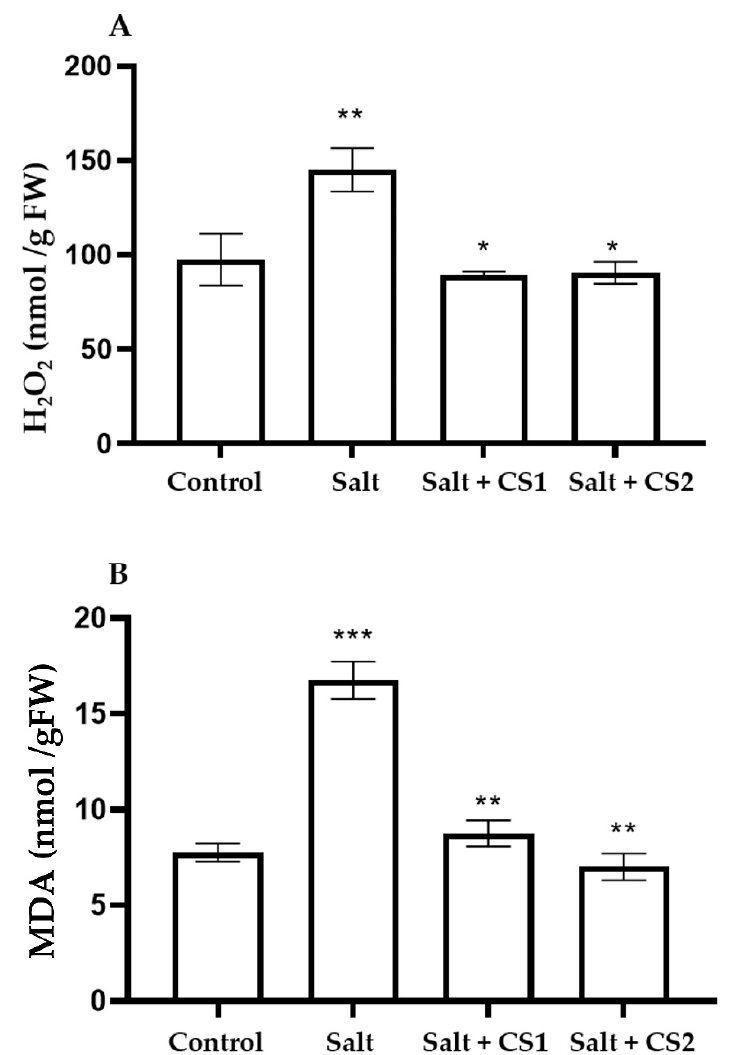
Figure 4. Chitosan (CS) reduces oxidative stress markers in sorghum under salt stress. ( A ) H 2 O 2 and ( B ) MDA content in control (0 mM NaCl) and salt (300 mM NaCl) treated sorghum supplemented with chitosan (CS1 = 0.25 mg/mL and CS2 = 0.5 mg/mL). Error bars represent the SD calculated from three biological replicates. The statistical significance between control and treated seedlings was determined using a two-way ANOVA conducted on GraphPad Prism 9.2.0, shown as *** = p ≤ 0.001, ** = p ≤ 0.01, and * = p ≤ 0.05.